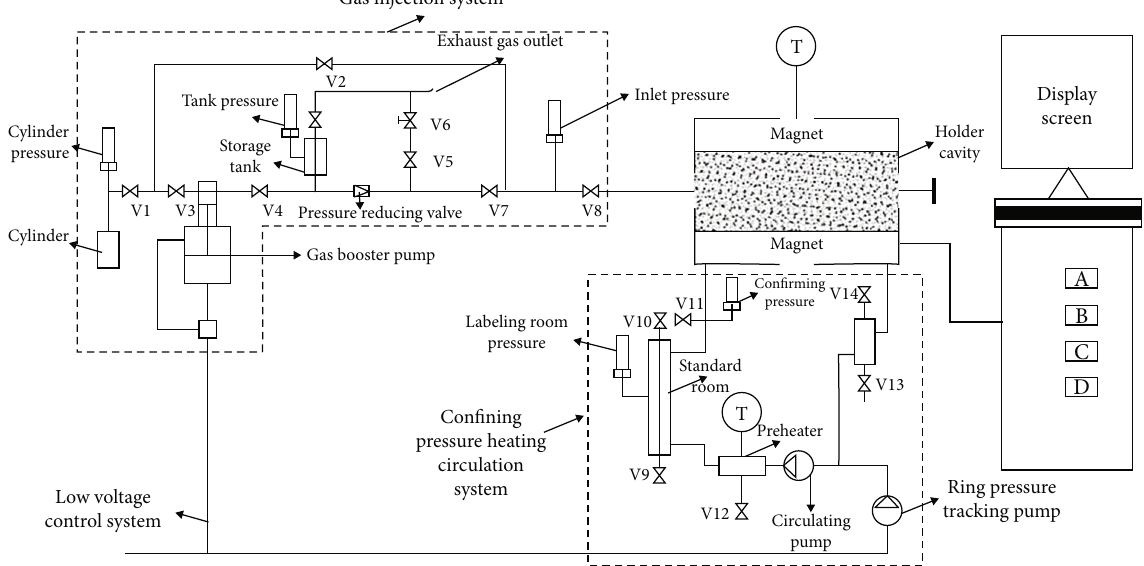
Figure 1: Schematic diagram of methane adsorption low- fi eld nuclear magnetic resonance experimental system.